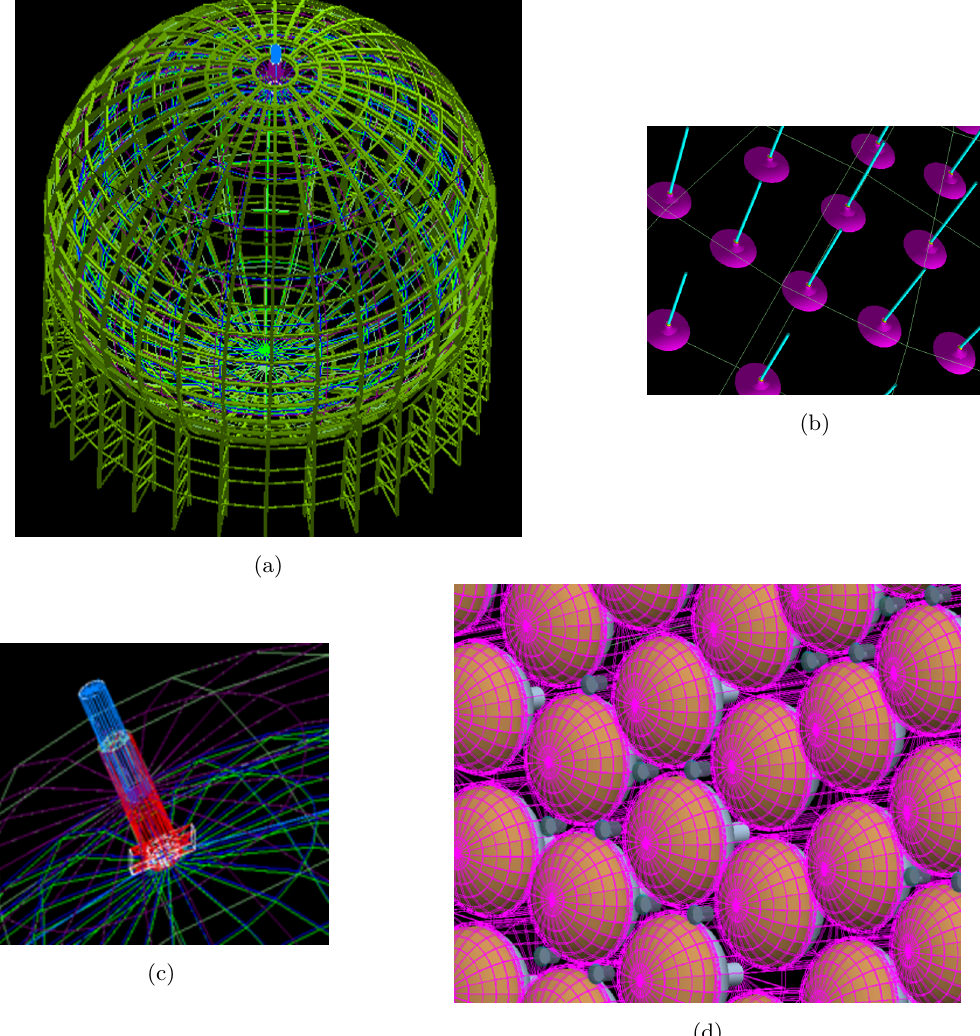
Figure 11. Details of the JUNO experimental setup as reconstructed by the SNiPER simulation code: a) SS truss supporting the PMTs and the acrylic sphere; b) Acrylic sphere containing the LS with bars on the outside for the connection to the steel truss; c) Chimney between the central detector and the calibration house on the top; d) Large and Small PMT